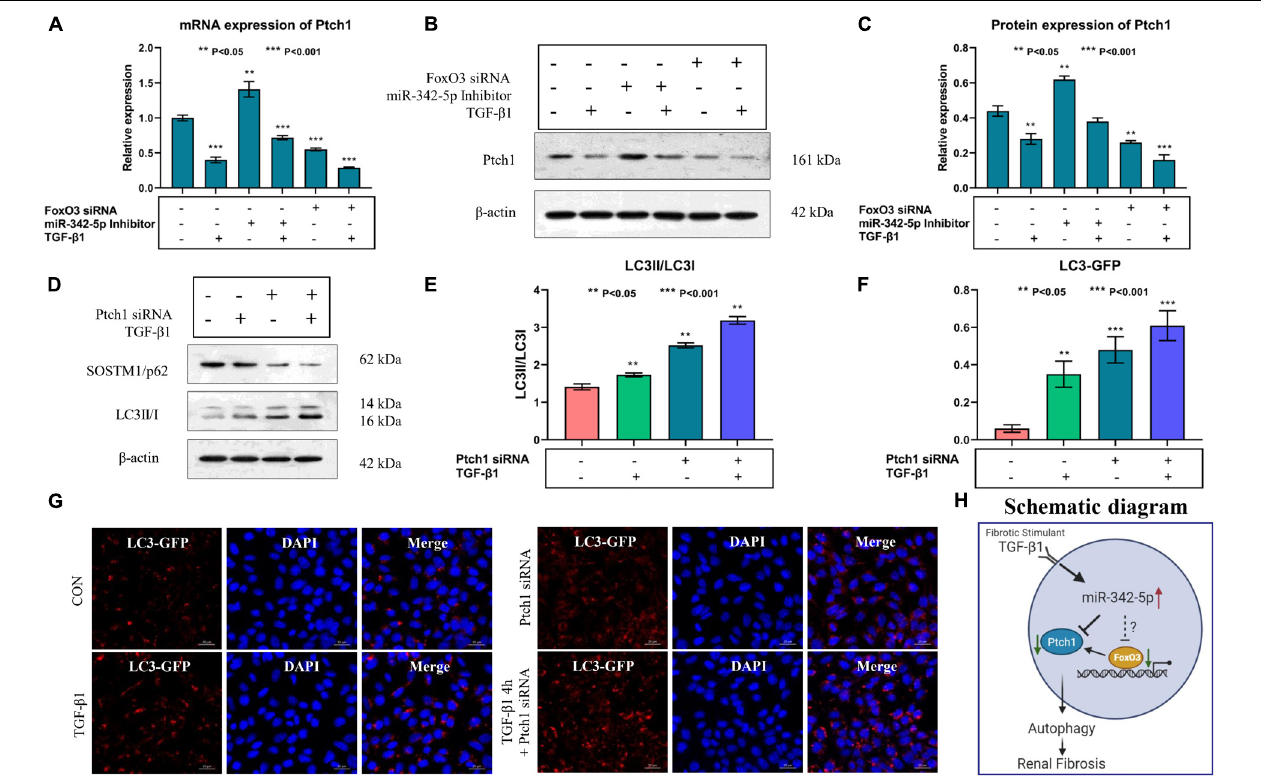
FIGURE 6 | Downregulation of Ptch1 induced autophagy in TCMK-1 cells. (A–C) Real-time PCR and western blot showing that downregulation of miR-342-5p reverses TGF- β 1-mediated inhibition of the expression of Ptch1 in TCMK-1 cells, while the downregulation of FoxO3 promotes TGF- β 1-mediated inhibition of the expression of Ptch1 in TCMK-1 cells. (D,E) Western blot showing that knockdown of Ptch1 in TCMK-1 cells increased expression of SOSTM1/p62 and LC3II/LC3I. (F,G) Quantification of immunofluorescent LC3-GFP puncta showing that Ptch1 knockdown enhanced autophagy, as evidenced by an increase in the number of GFP-LC3 spots. (H) A simple schematic diagram showing the relationship between miR-342-5p, FoxO3, and Ptch1 in the progression of RF, and the role of autophagy in